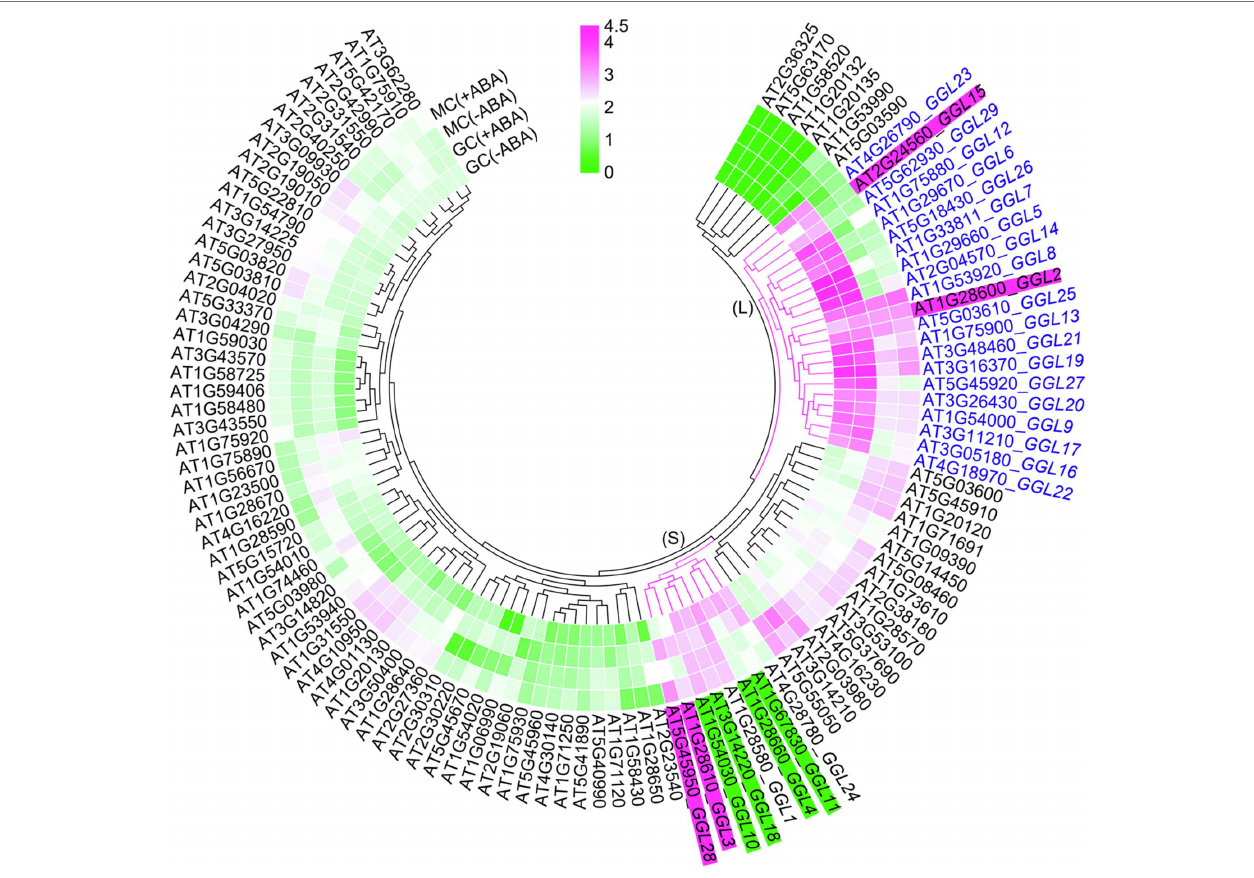
FIGURE 1 | Identification of GGLs in Arabidopsis . Expression levels of Arabidopsis GDSLs in guard cell and mesophyll cell protoplasts in response to ABA or not. ATH1 microarray data of all Arabidopsis GDSLs in guard cell (GC) and mesophyll cell (MC) protoplasts treated with ABA or not were obtained from Leonhardt et al. (2004) and Yang et al. (2008). Putative GDSLs were merged from Dong et al. (2016) and Lai et al. (2017). The heat map was constructed by TBtools (Chen et al., 2020), and the color code of signal intensities corresponds to the abundance of transcripts, from low (green) to high (magenta) expression. GGL means G uard-cell- enriched G DSL L ipase . (L) and (S) indicate the large and small clades, respectively. Nineteen GGLs in L clade were shown in blue fonts. The GGLs highlighted in magenta or green indicated the GGLs in guard cell protoplasts induced or repressed by ABA treatment,